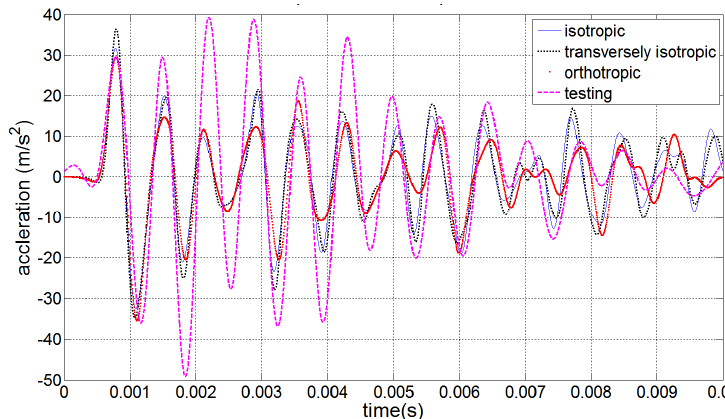
Figure 10. Response comparison between results from three FE models and experimental measurements.